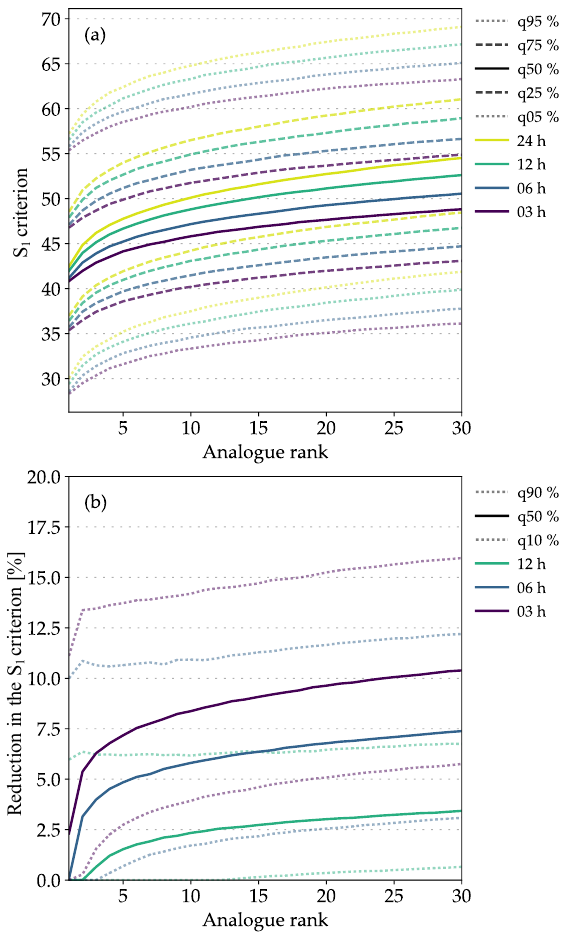
Figure 5. Distribution of the median improvements of the S 1 crite- rion due to the (a) 3h MTW and (b) 6h MTW, depending on the daily precipitation thresholds at the Ulrichen